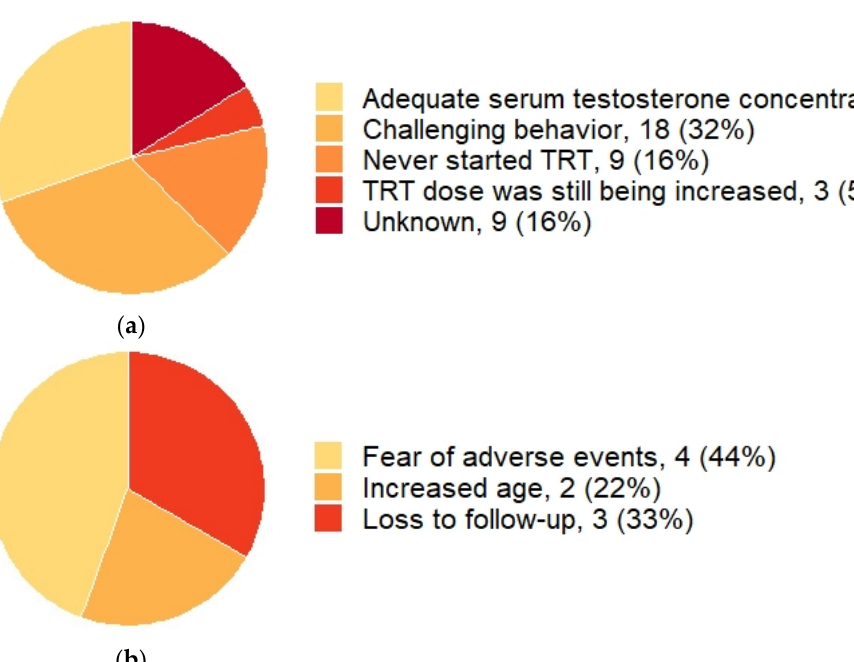
Figure 2. Serum testosterone concentrations according to testosterone dose for patients using testosterone gel. Laboratory measurements were only available for 22 males. Testosterone gel was administered by the patient in the morning. Testosterone measurements before 11:00 A.M. are depicted in black, between 11:00 A.M. and 3:00 P.M. in orange and after 3:00 P.M. in red. Only two brands were used; Androgel ® is depicted with circles and Tostran ® with triangles. When two points overlapped, one of the points was moved 1 mg to the right and this point is depicted with an open circle or triangle instead of closed.